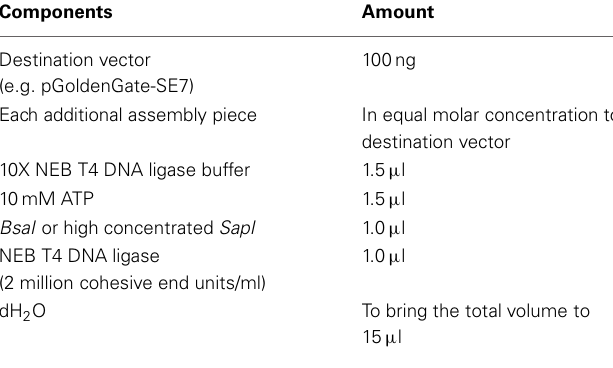
Table 1 | Assembly of Golden Gate